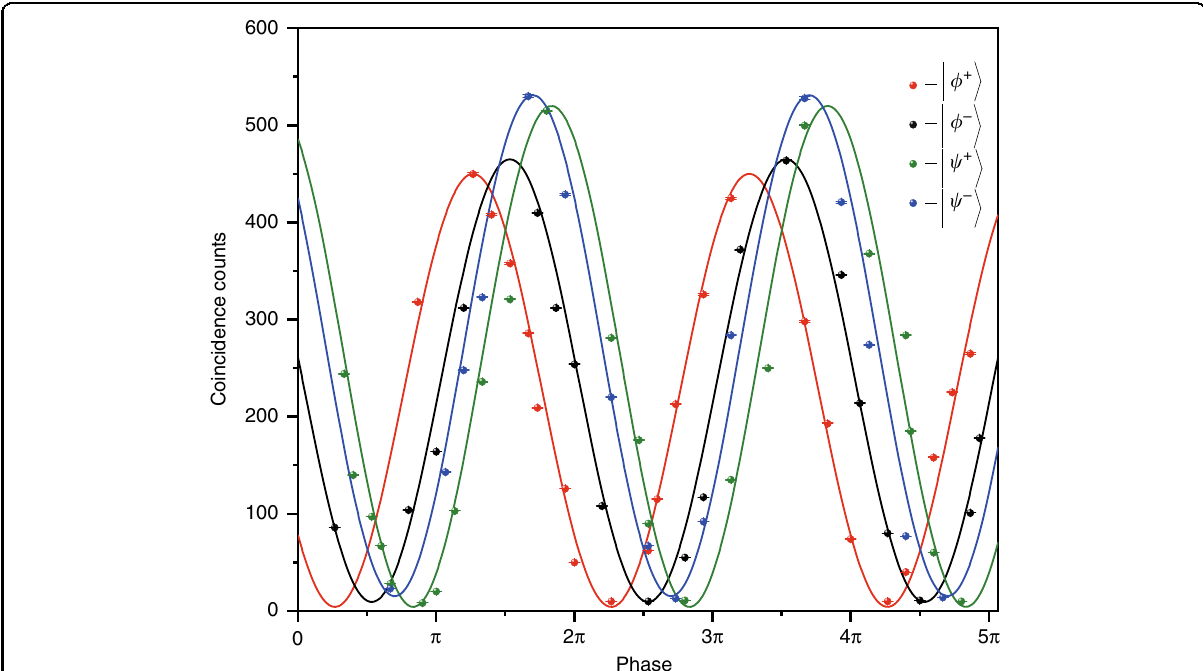
Fig. 4 Experiment results. We measured two-photon interference fringe for four Bell states with subtraction of accidental coincidences. Note that the y axis represents the coincidence count varied with the full control of the phase over 2 π rad.